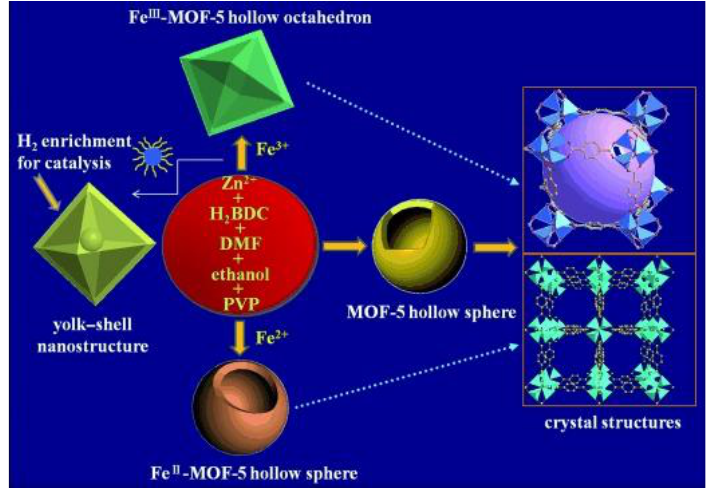
Figure 6. Proposed formation process of different MOF hollow nanocages. Reprinted with permission from Ref. [43]. Copyright 2014, Wiley-VCH Verlag GmbH.